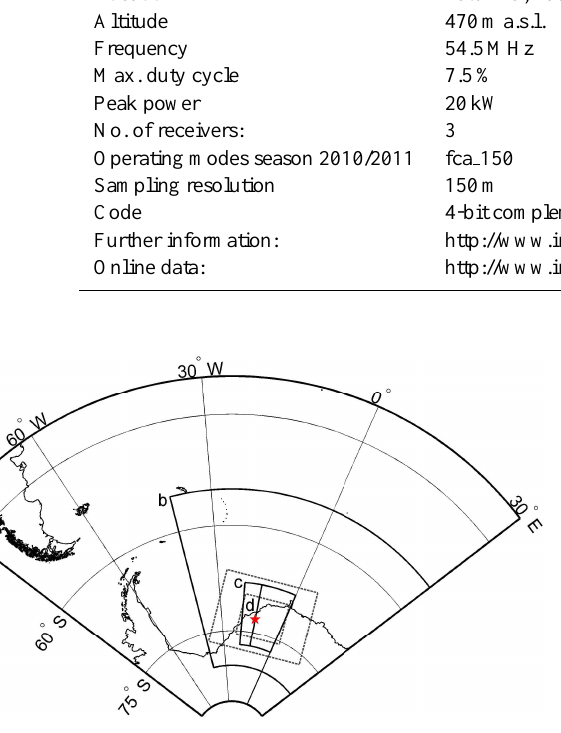
Fig. 2. Map grids used in this paper. Outer frame (a) used for the synoptic overview (Fig. 3), (b) ECMWF operational analysis tropopause maps (Fig. 4 – a), (c) WRF model tropopause maps (Fig. 4 – b) (d) vertical cross-sections along the 13.5 ◦ W longitude (Fig. 5). Red star – position of MARA radar. Dashed lines represent the outer and inner domains used in WRF model